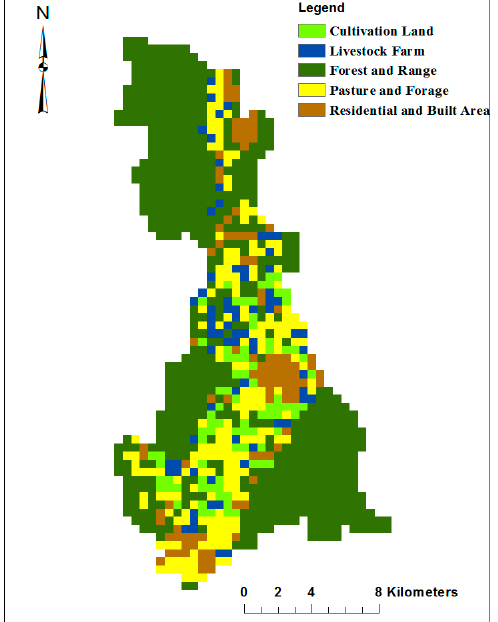
Figure 2. Major land uses and their spatial distribution in the study area for year 2008.